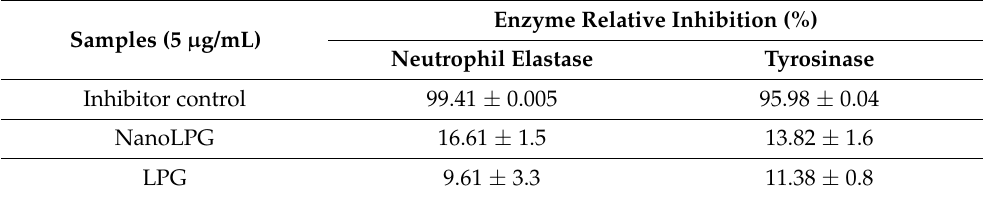
Table 3. Enzyme relative inhibition of free LPG and nanoLPG at a concentration of 5 µ g/mL. Samples (5 µ g/mL)